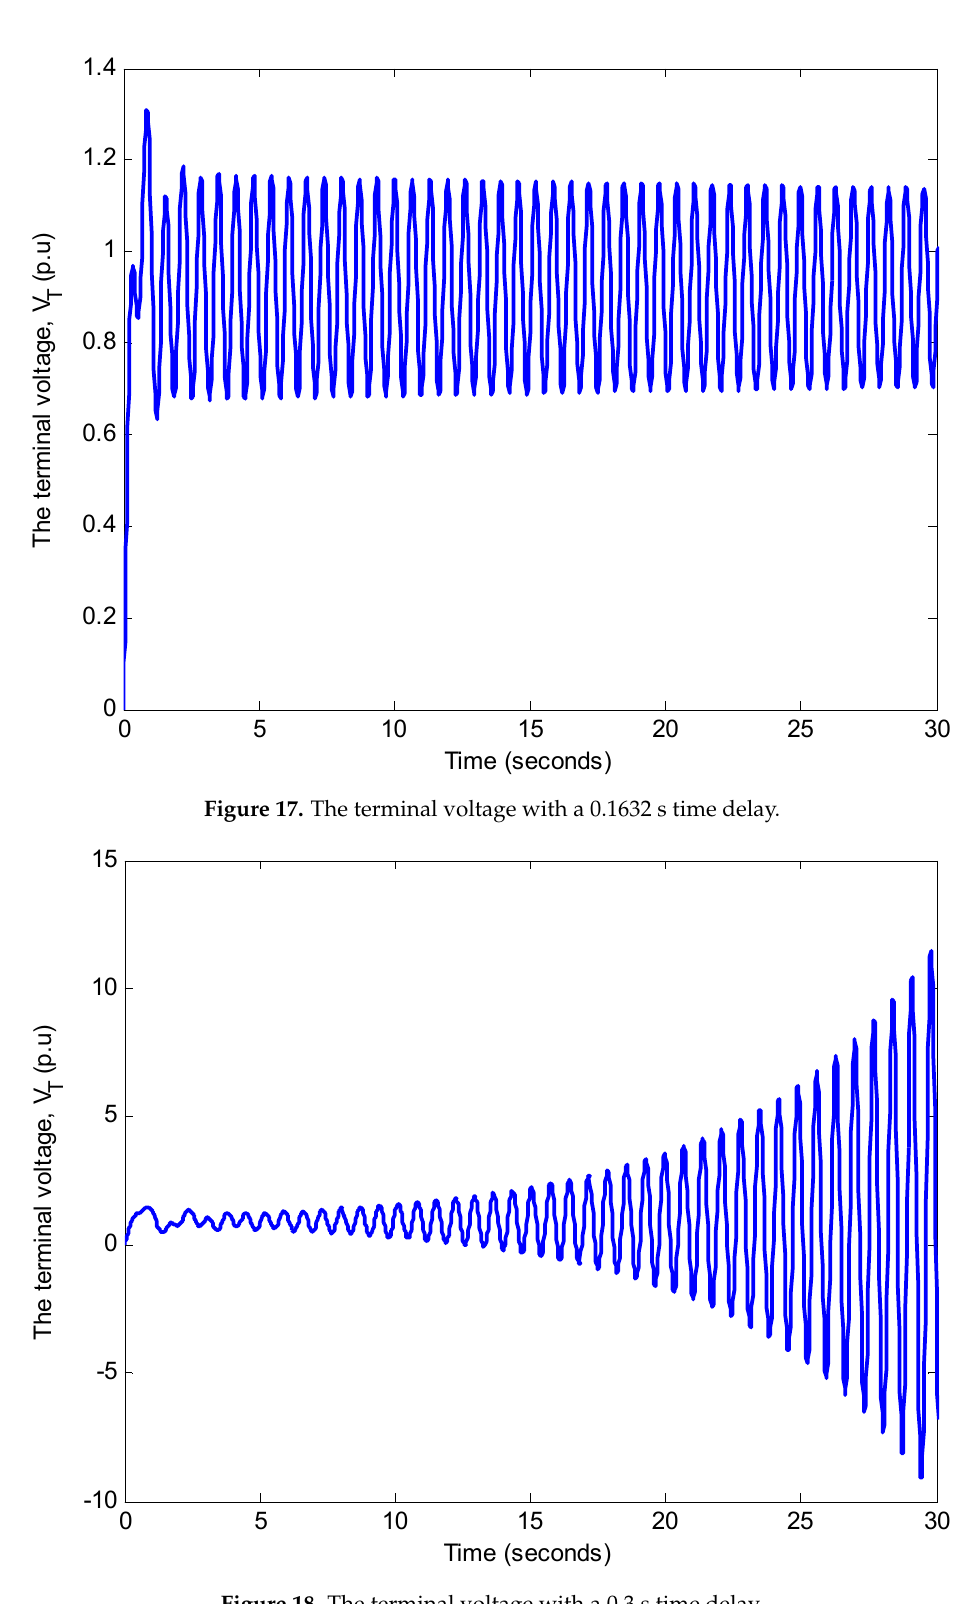
Figure 16. The terminal voltage with a 0.16 s time delay.